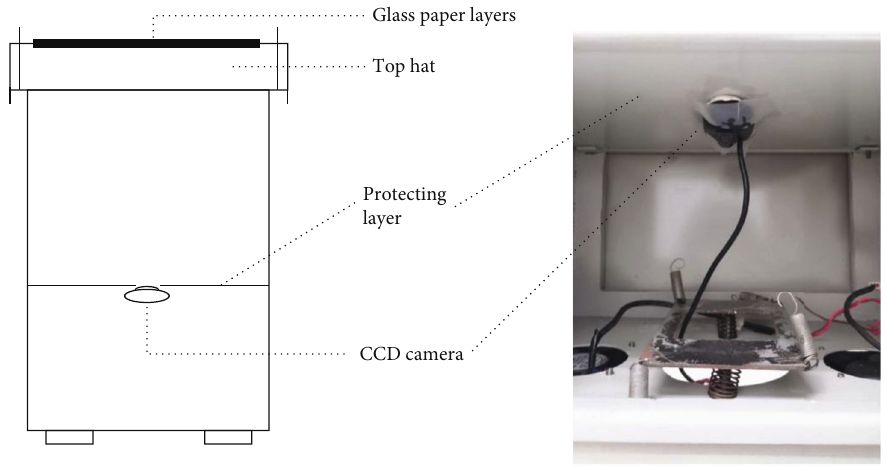
Figure 11: Experiment setup for accuracy measurement experiments.